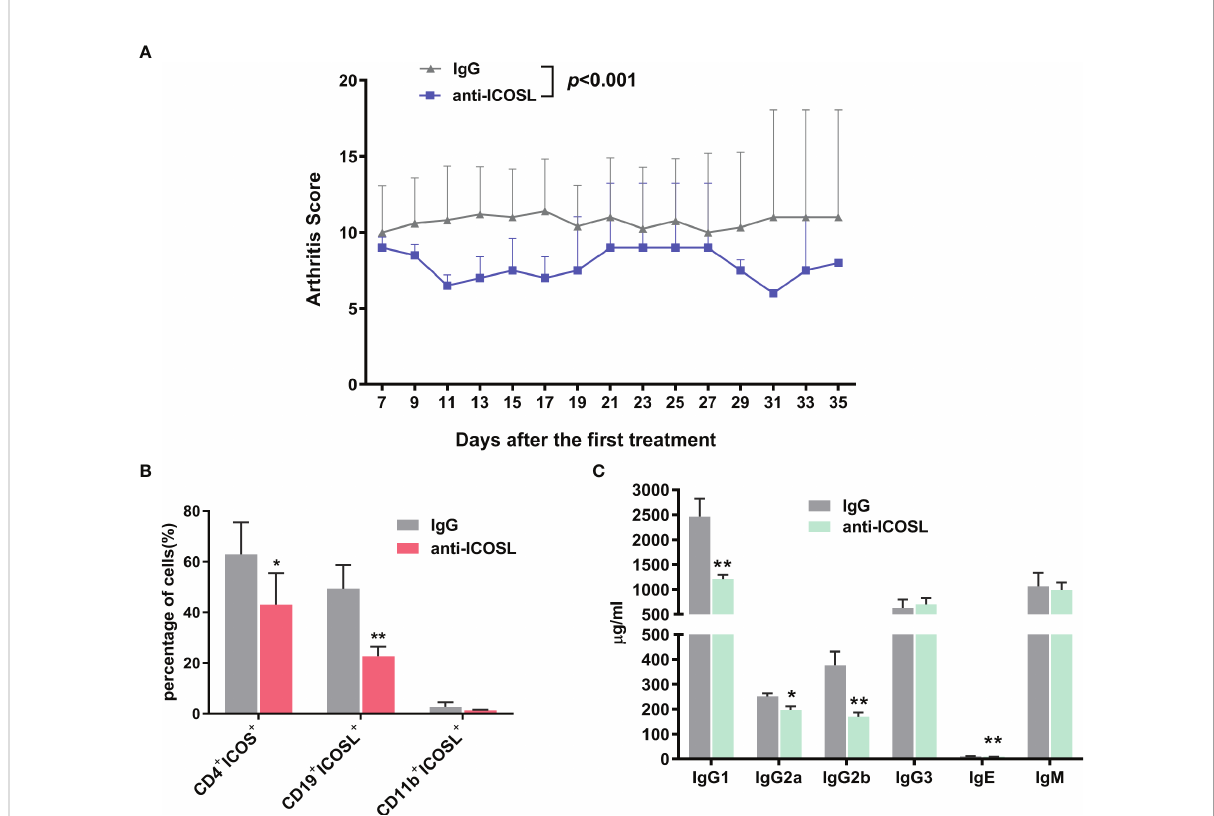
FIGURE 8 BlockadeofICOSL invivo . (A) ThearthritisscoresofCIAmicetreatedwithanti-ICOSLmAb(n=5)andIgG(n=5). (B) ThepercentagesofCD4 + ICOS + T